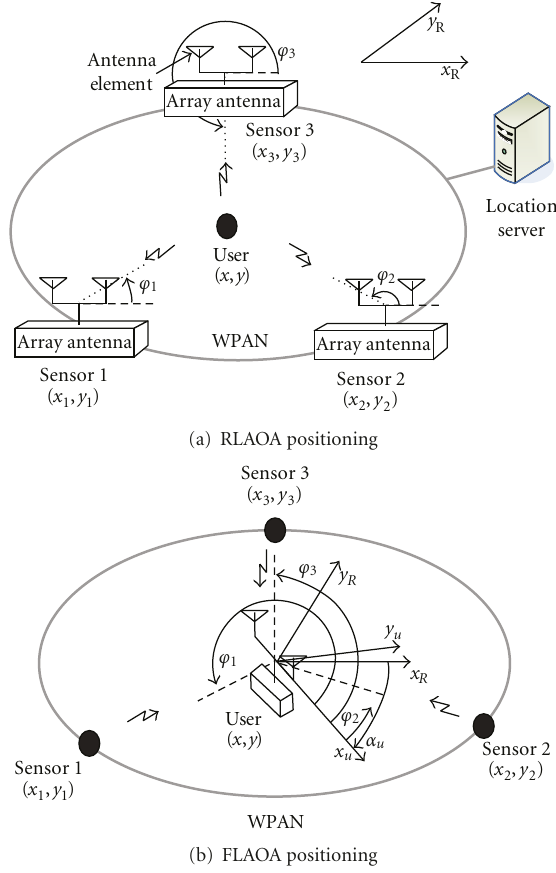
Figure 2: Basic principles of RLAOA and FLAOA.